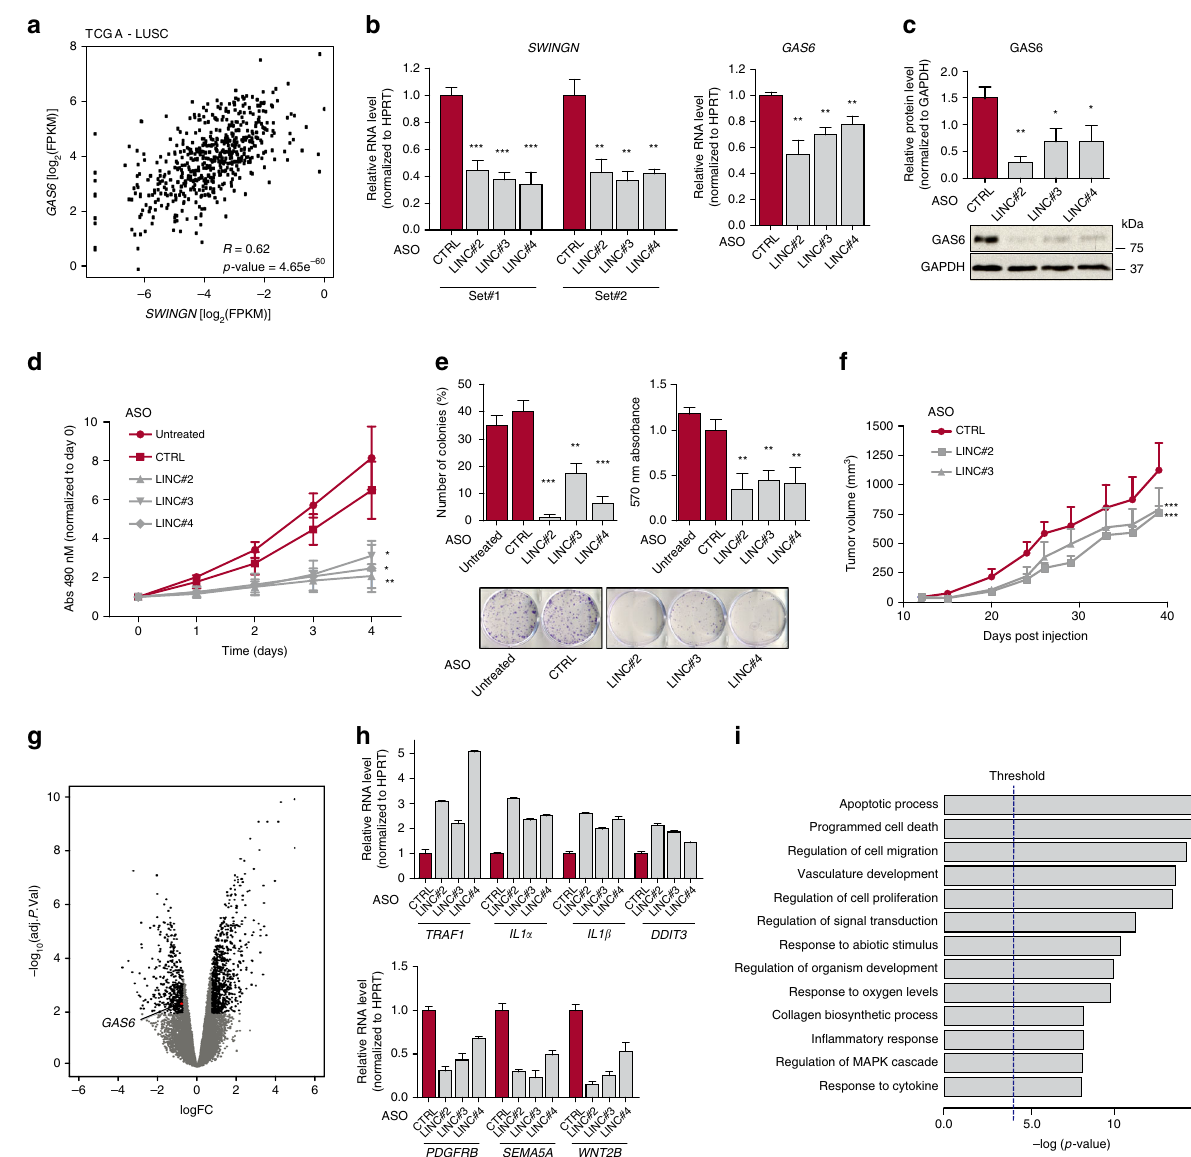
Fig. 4 SWINGN -mediated GAS6 regulation is relevant in cancer progression. a Correlation plot showing SWINGN and GAS6 expression (as FPKM + pseudocount values) in LUSC samples ( n = 552) from TCGA database (gdc-portal.nci.nih.gov). Correlation p -value is calculated using a t-distribution. b , c RT-qPCR ( b ) and Western blot ( c ) analysis of H226 lung squamous carcinoma cells depleted of SWINGN . RNA levels were normalized to ASO_CTRL and detected with two different primer sets. Graphs show mean ± SEM of normalized values ( n = 3); image is from a representative experiment. d MTS proliferation assay of control and SWINGN -depleted H226 cells. Absorbance values were normalized to day 0. Graph shows mean ± SEM ( n = 3). T -test p - value is calculated with data points at day4: * < 0.05; ** < 0.01. e Clonogenicity assay of control and SWINGN -depleted H226 cells. Number of colonies (left) and cell density by absorbance (right) are shown. Graph shows mean ± SD of two independent experiments, picture refers to a representative experiment. f Analysis of tumors generated by subcutaneous injection of control or SWINGN -depleted H226 cells in BALB/cA-Rag2 − / − γ c − / − mice. Graph shows tumor size mean ± SEM ( n = 7); statistical signi fi cance was calculated using one-way ANOVA and Bonferroni ’ s Multiple Comparison Test compared to ASO_CTRL. g Volcano plot of RNA-seq analysis of H226 cells depleted of SWINGN using ASO_LINC#3 or treated with control ASO. Black dots indicate genes with a signi fi cant change comparing the two conditions (Adj. p -value < 0.01; logFC ± 0.5). Adj. p -value is calculated by quasi-likelihood (QL) F -test with Benjamini-Hochberg correction. h RT-qPCR validation of a selection of the most affected genes obtained in the RNA-seq analysis in H226 cells. Upper and lower panels show upregulated and downregulated gene candidates, respectively. RNA levels were normalized to ASO_CTRL values. i Gene Ontology (GO) analysis illustrating the biological processes enriched for the 1641 differentially expressed genes identi fi ed in RNA-seq data of control and SWINGN -depleted H226 cells. Threshold: p -value < 10 − 4 . p -value derived by random sampling of the whole genome combined with Fisher ’ s inverse chi-square method. Source data for panels b – h are provided as a Source Data fi le. Student ’ s t -test p -values in b – e summarized as follows: * < 0.05; ** < 0.01; *** <